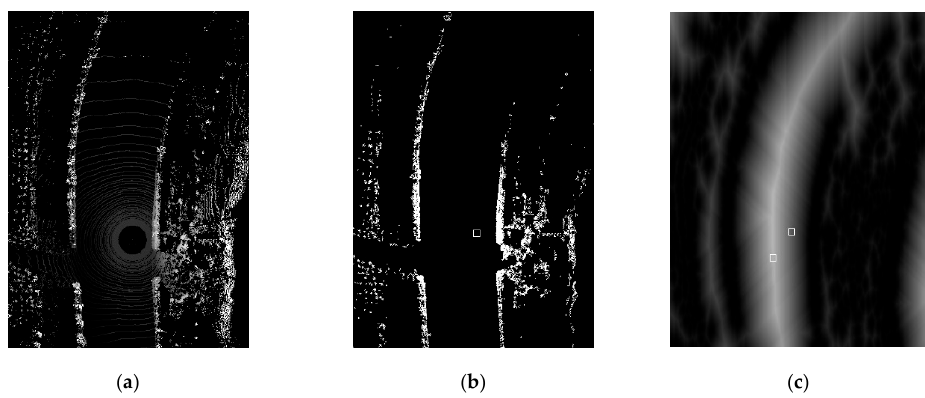
Figure 13. Result of obtaining the nearest local maximum point. ( a ) Raw point cloud map; ( b ) Obstacle map; ( c ) Distance map.